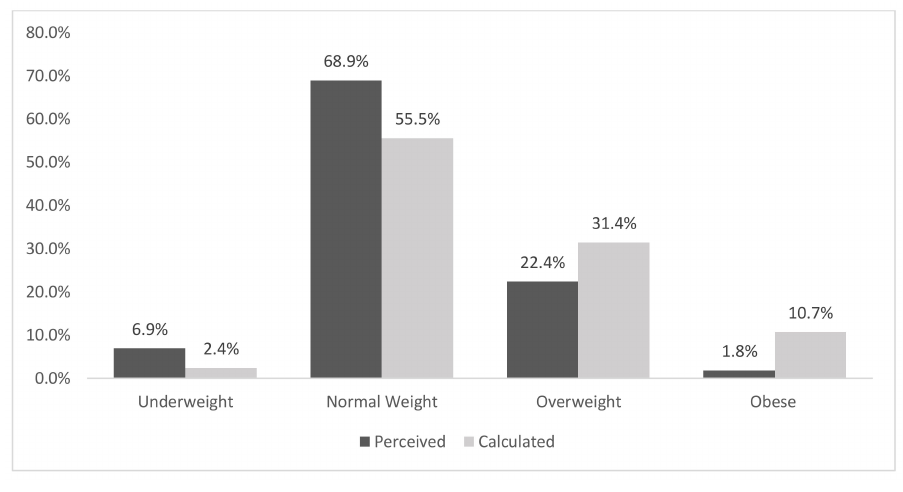
Figure 2. Perceived versus calculated BMI category classifications (males, n = 974). Kappa Measure of Agreement 0.32, p <